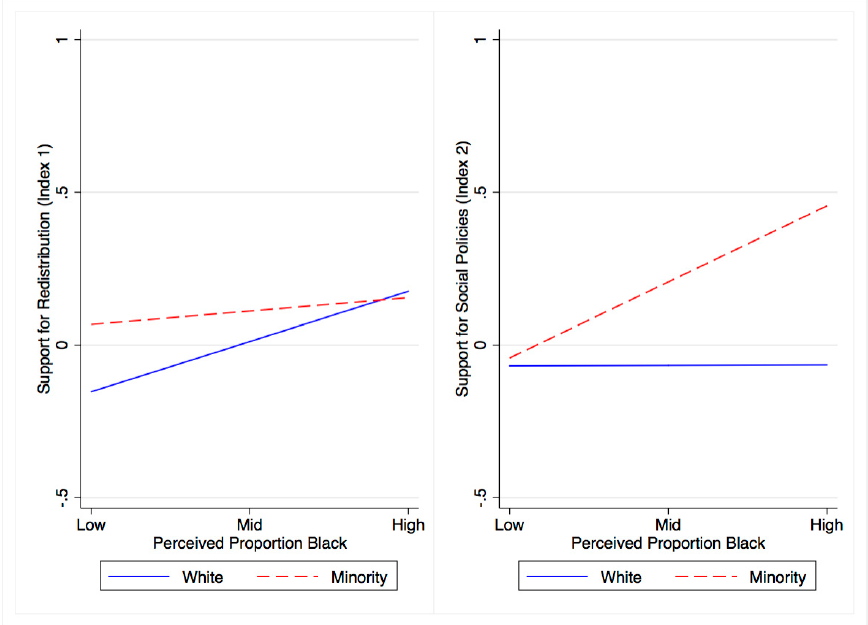
Figure 7. Bivariate fitted linear regression lines of support for redistribution and social policies indices (standardized) and perceived neighborhood proportion of blacks by respondent race.